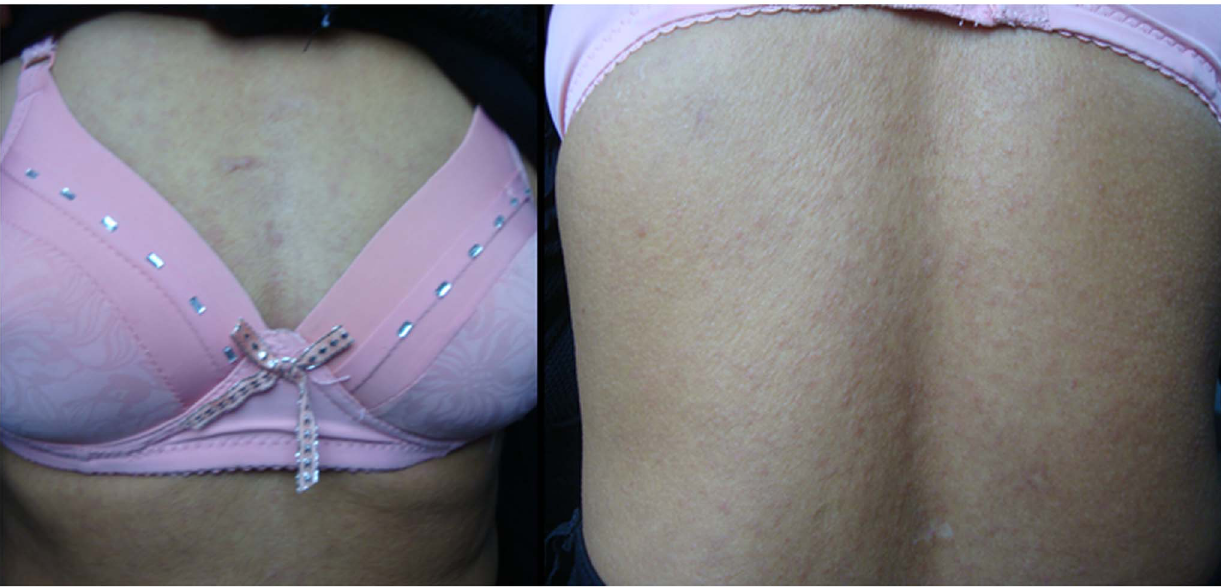
Figure 3. Clinical manifestations of the second patient when she was admitted for the first time. Intensive popular exanthematous rash was found on her